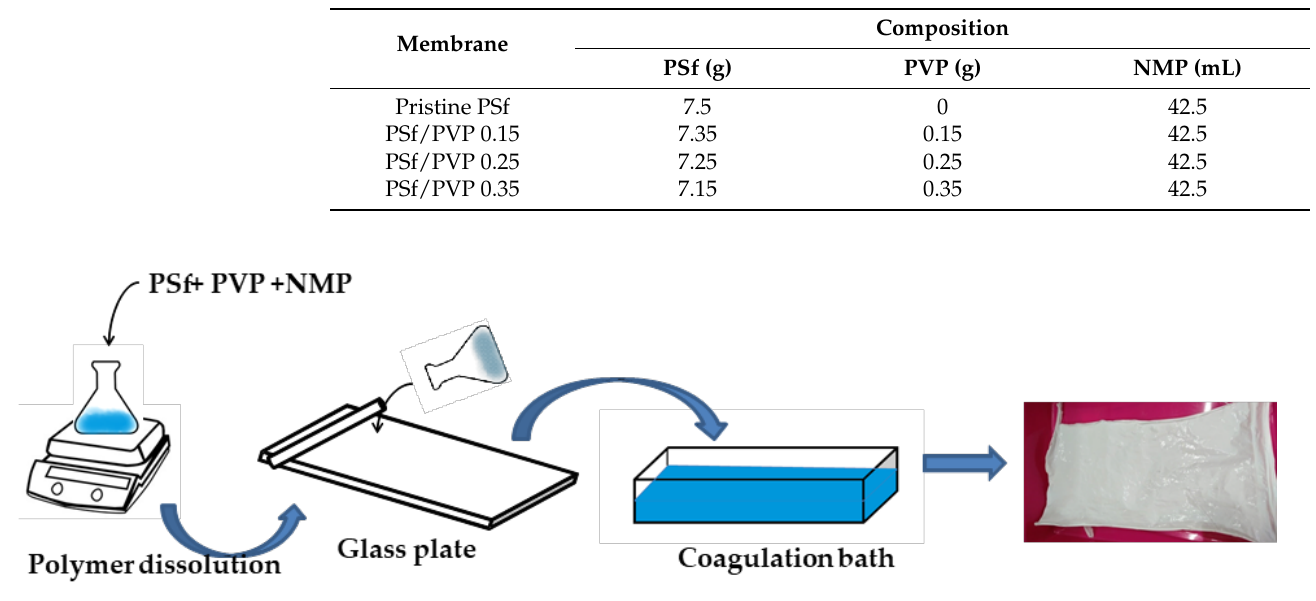
Figure 1. Illustration of membrane preparation.